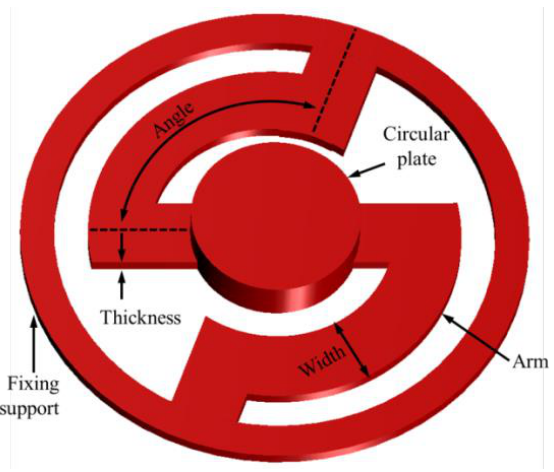
Figure 4. The geometrical shape of the cantilever membrane.